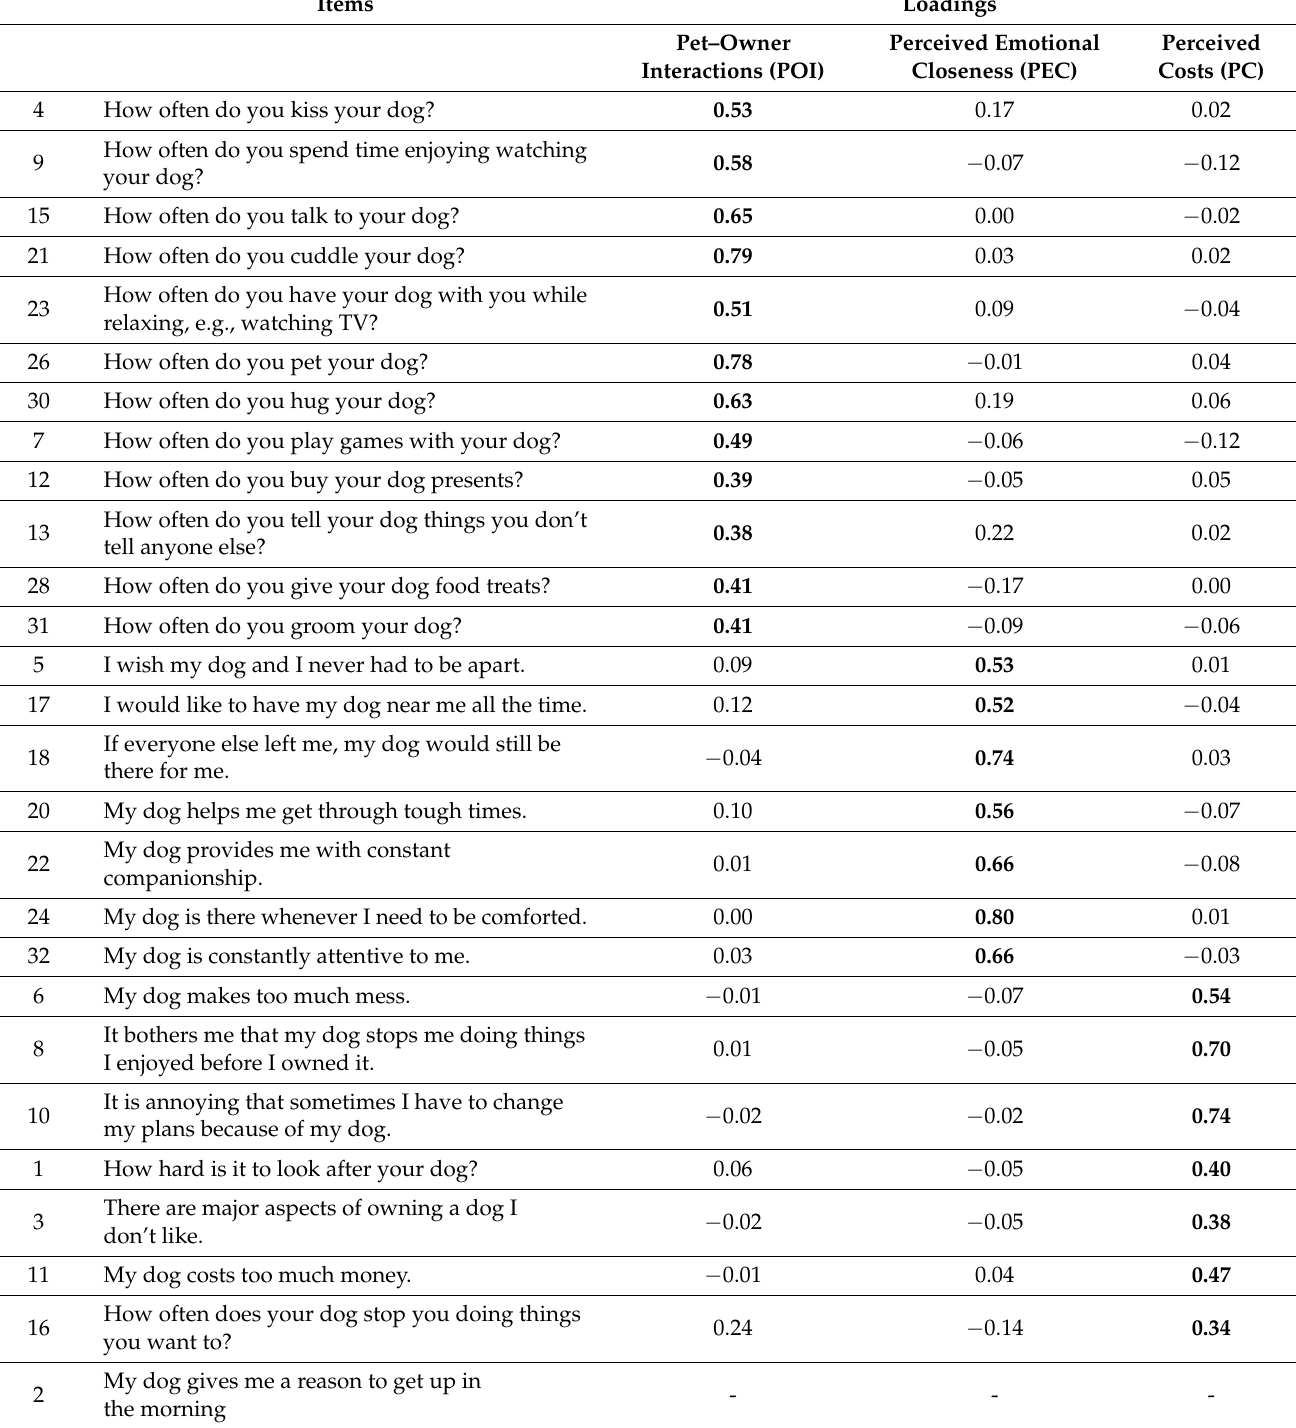
Table 3. Results of the C/DORS’ EFA and factor loadings. The highest loading for each item is in bold. Items Loadings Pet–Owner Interactions